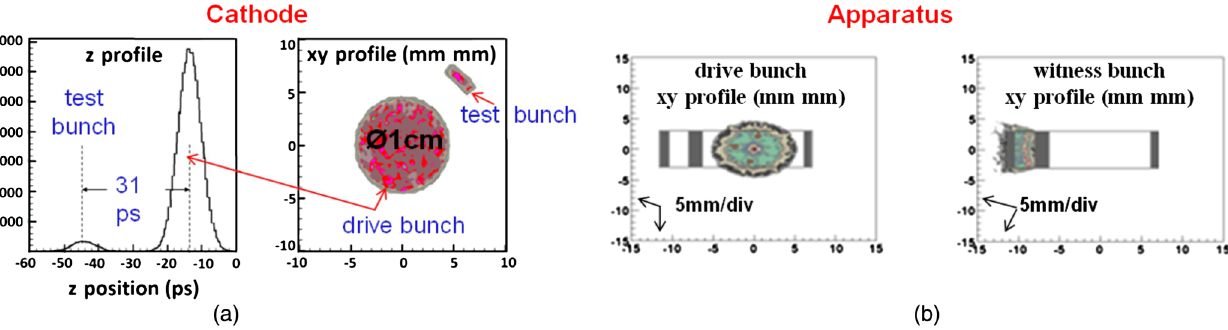
FIG. 10. Simulations indicate that both bunches produced at the cathode (a) can be guided and focused to the correct locations when delivered to the apparatus (b). The simulation is done for 10 5 particles [the left graph in (a) shows the number of particles vs initial z coordinate for both bunches].